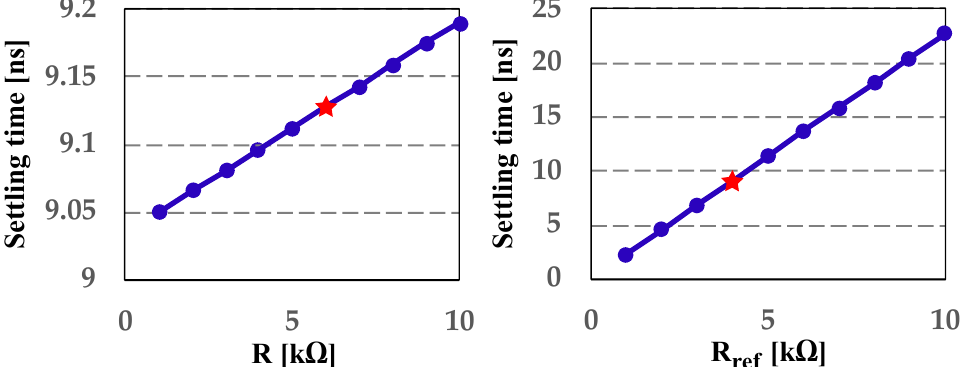
Figure 4. Required setting time according to R , R ref with MSB conversion